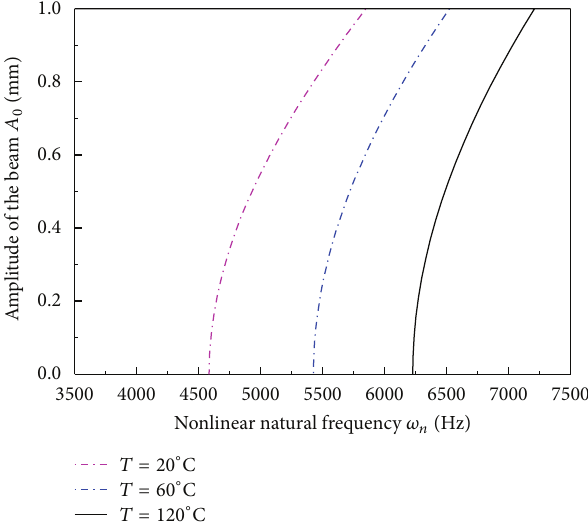
Figure 9: Variation of the nonlinear natural frequency with the free vibration amplitude 𝐴 0 for different 𝜀 0 ( 𝑉 𝑠 = 0.005 , T = 60 ∘ C, and 𝐿/ℎ = 10 ).